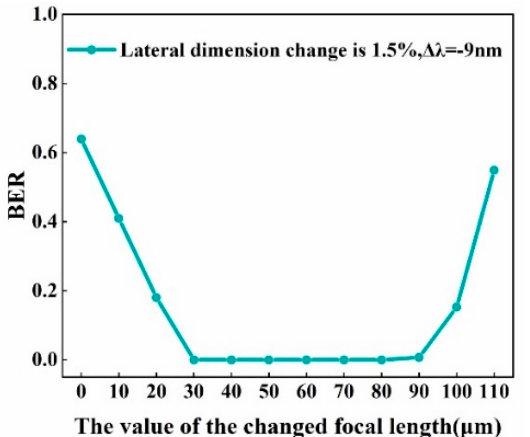
Figure 7. The BER with different focal length adjustments when the wavelength of the reading light was reduced by 9 nm and σ L was 1.5%.